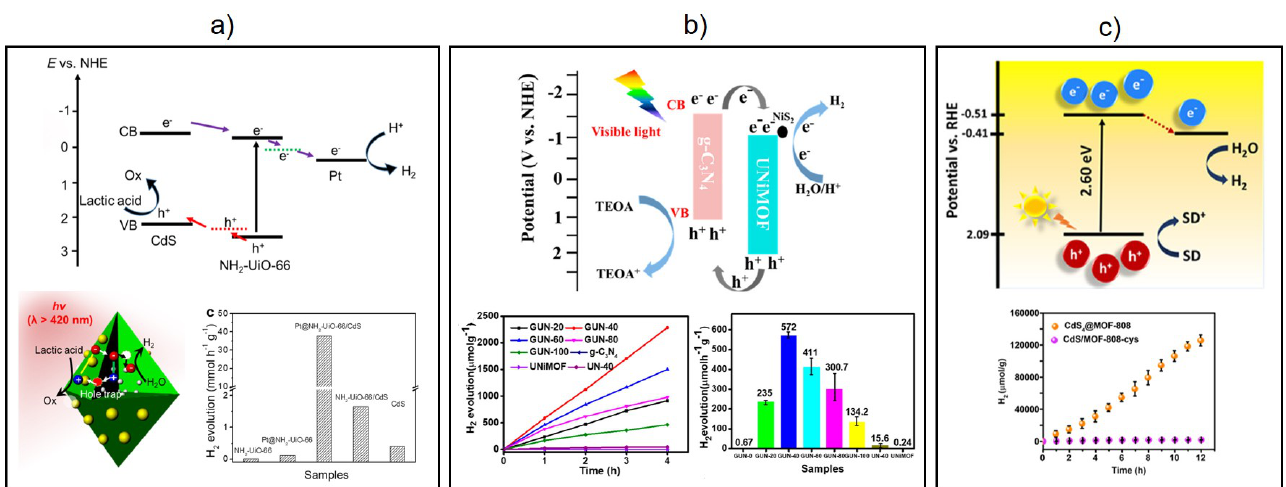
Figure 13. Proposed reaction mechanisms for the photocatalytic H 2 evolution and obtained H 2 production rates over different MS-based heterojunction photocatalysts. ( a ) ZnIn 2 S 4 @CoS 2 [127] Copyright © 2022 Springer Nature. ( b ) g-C 3 N 4 /UNiMOF/NiS 2 (GUN) [128] Copyright 2022, Ameri- can Chemical Society. ( c ) CdS@MOF-808 [129] Copyright © 2022, American Chemical